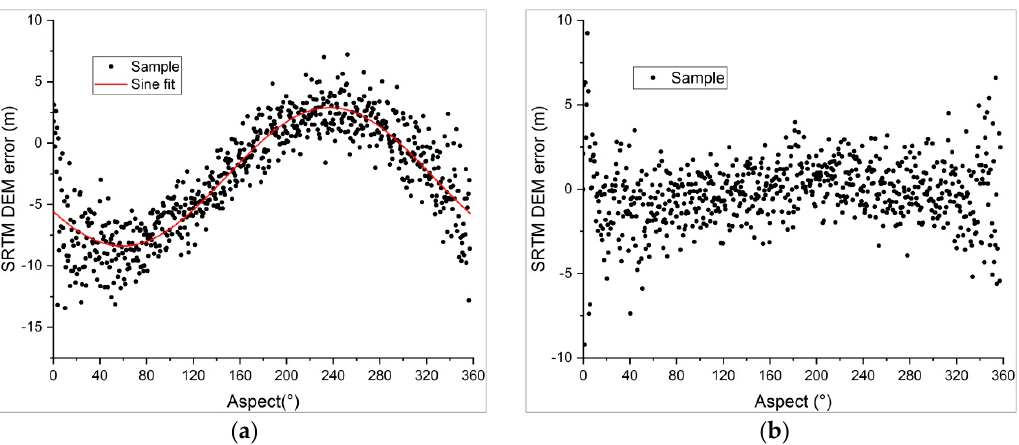
Figure 7. Relationship between terrain aspect and SRTM3 DEM error relative to ICESat/GLAS data ( a ) without and ( b ) with data coregistration.